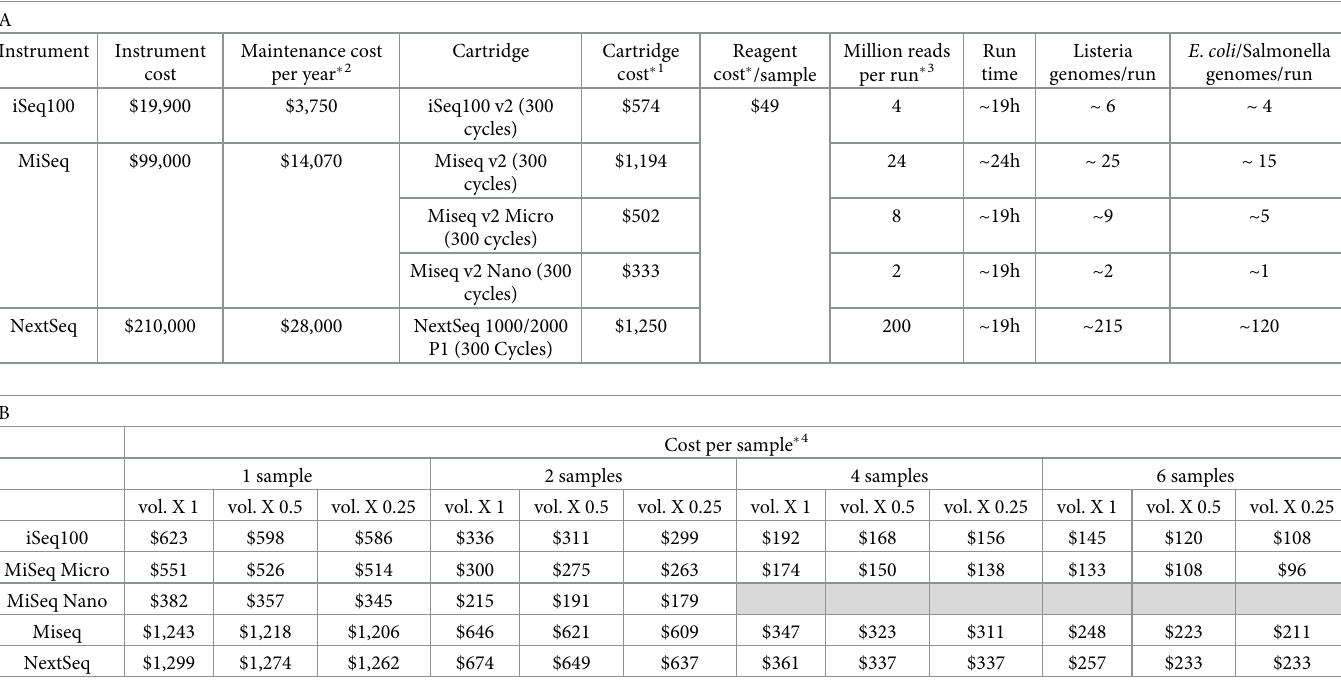
Table 2. An overview of the cost of using iSeq100, MiSeq, and NextSeq1000 as a diagnostic tool including, expenses associated with instrument acquisition and maintenance (A), and cost-cutting associated with reagent reduction during library prep for iSeq100